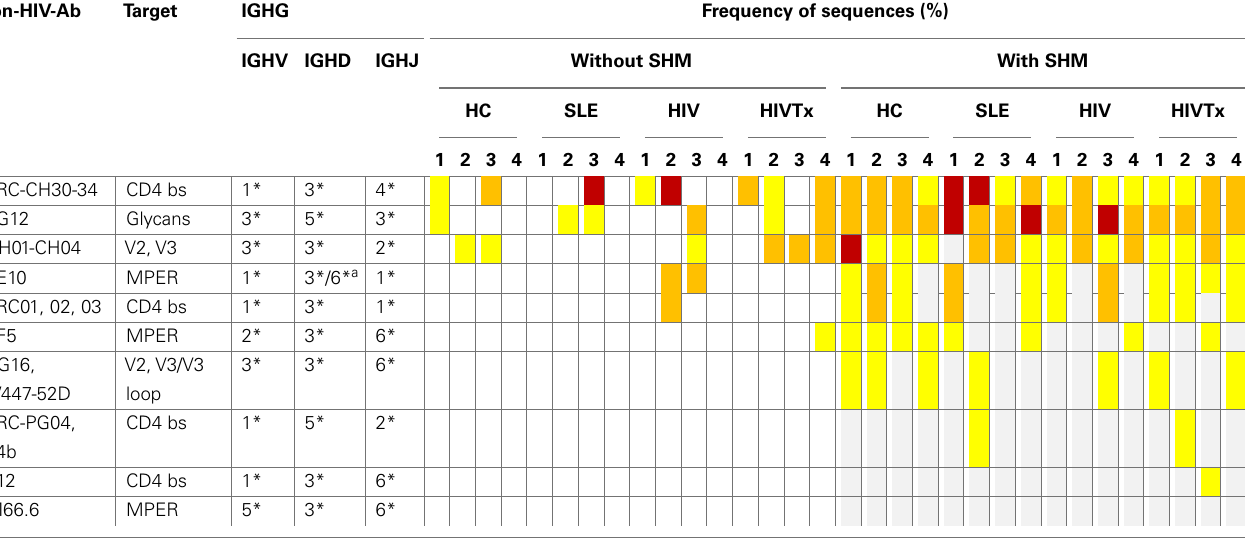
Table 4 | IGHV, IGHD, and IGHJ combinations similar to known bn-HIV-Ab in IgM repertoire in peripheral blood.